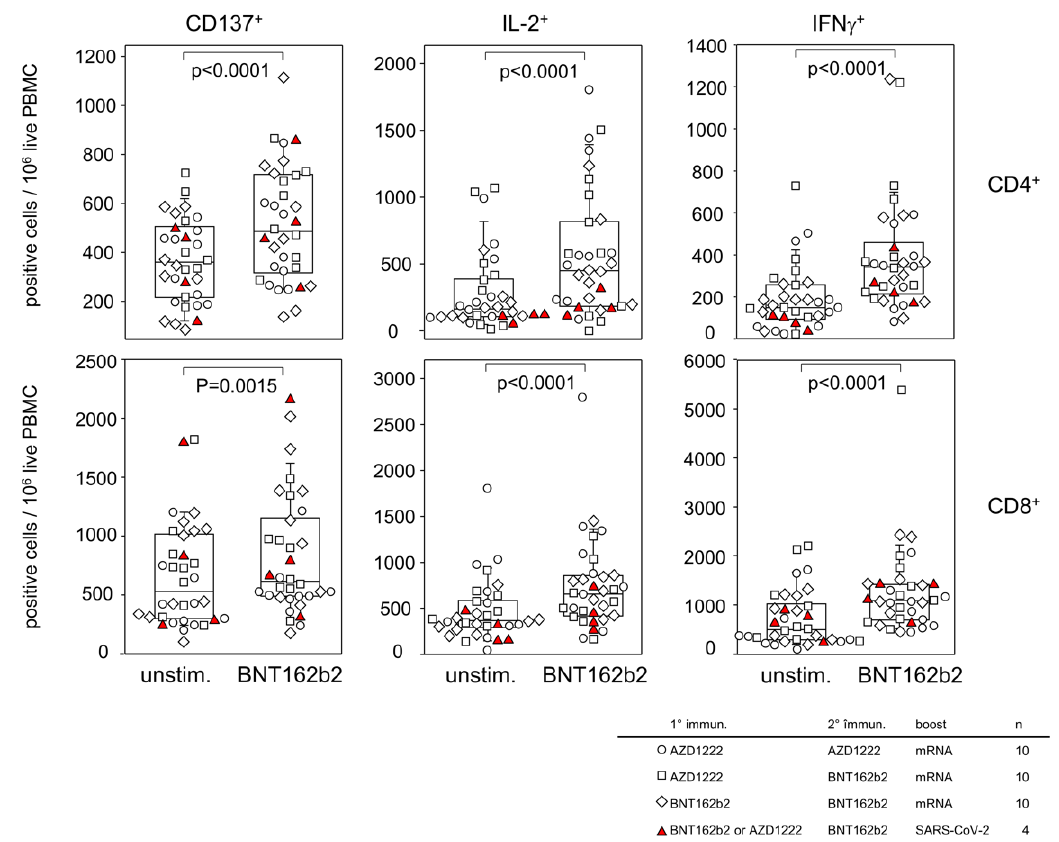
Figure 2. Homologous and heterologous vaccination regimen involving AZD1222 and BNT162b2 resulted in comparable T cell memories. Dot blots and corresponding box plots show increased numbers of CD137-, IL-2- and IFN γ -positive cells following in vitro re-stimulation of PBMC with BNT162b2. Different symbols represent different vaccination regimen as indicated in the table. p values result from Wilcoxon Matched Pairs Signed Rank Test.